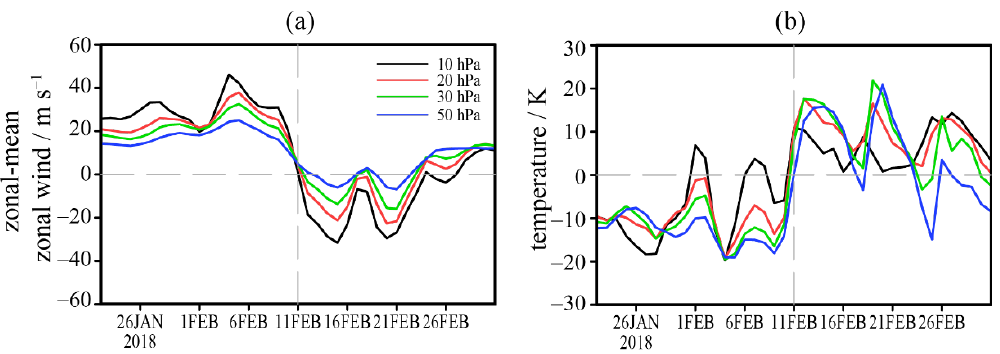
Figure1. Temporalevolutionsof( a )thezonal-meanzonalwindaveragedin60–75 ◦ Nand( b )meridional Figure 1. Temporal evolutions of ( a ) the zonal-mean zonal wind averaged in 60° – 75° N and ( b ) gradient of zonal-mean temperature between 60 ◦ N and the North Pole at 10–50 hPa during the period meridional gradient of zonal-mean temperature between 60° N and the North Pole at 10 – 50 hPa 22 January–3 March 2018 (within 40 days before and after the onset date of stratospheric sudden during the period 22 January – 3 March 2018 (within 40 days before and after the onset date of warming (SSW) shown by the vertical dashed stratospheric sudden warming (SSW) shown by the vertical dashed line).